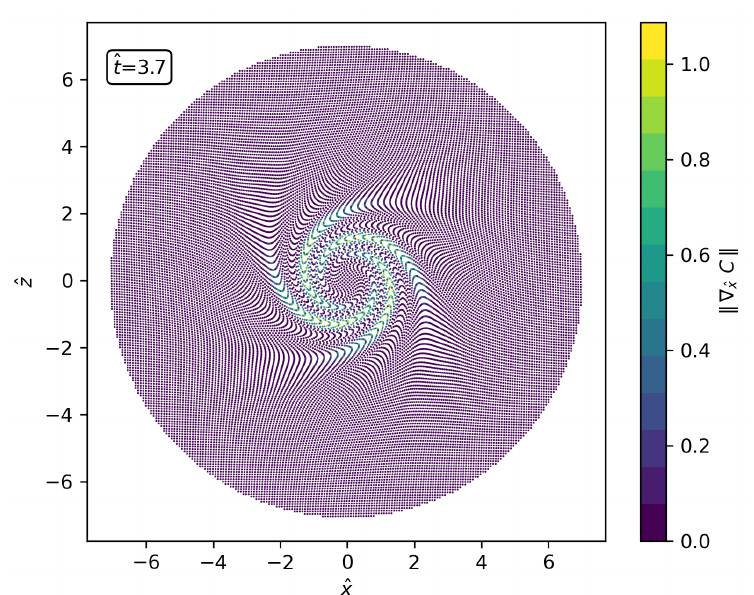
Figure 4. Distribution of particles of the 2D vortex simulation (with the RSPH-WENO scheme) at ˆ t = 3.7, with the magnitude of the gradient of partition of unity superimposed. The resolution is R / ∆ x = 92.